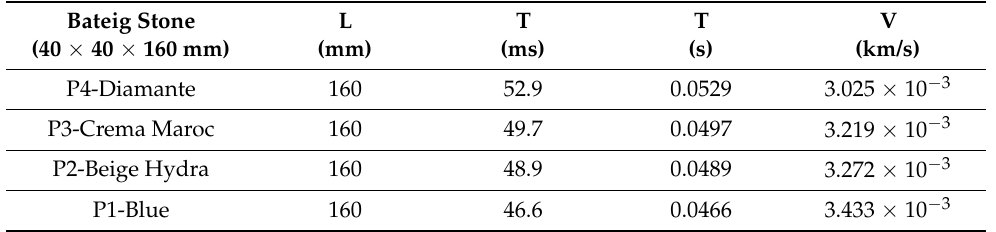
Table 6. Direct ultrasonic testing of Bateig stone specimens treated with MYXOSTONE M3P (mean